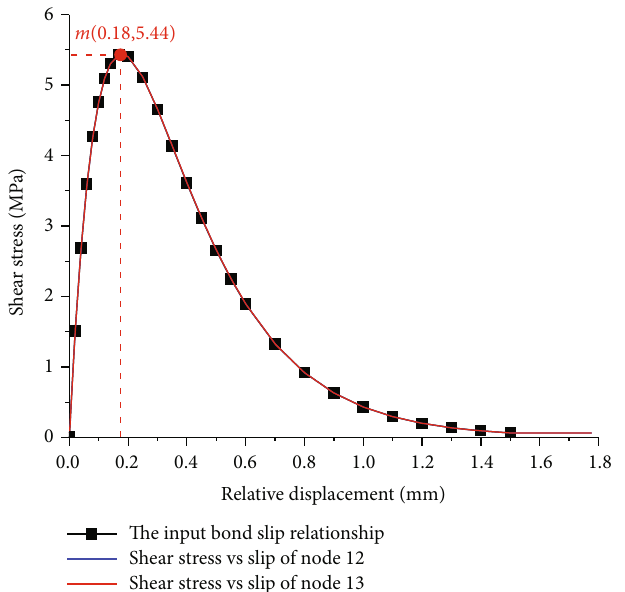
Figure 6: Comparison of bond slip curves at di ff erent nodes (nodes 12 and 13) with the input bond slip